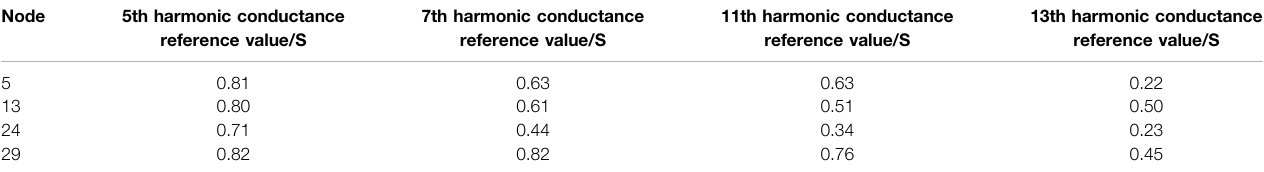
TABLE 3 | Global optimization results of VDAPF harmonic equivalent conductance under scenario 2.